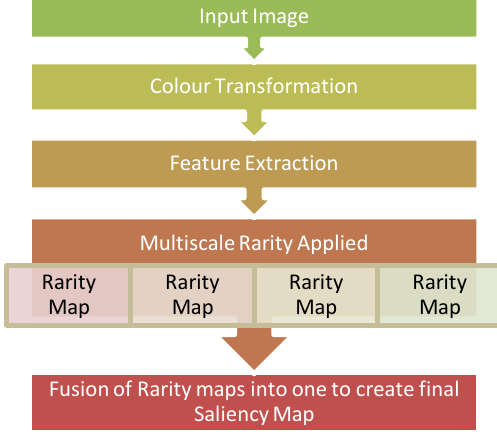
Figure 2 Work Flow diagram of RARE2012 Saliency